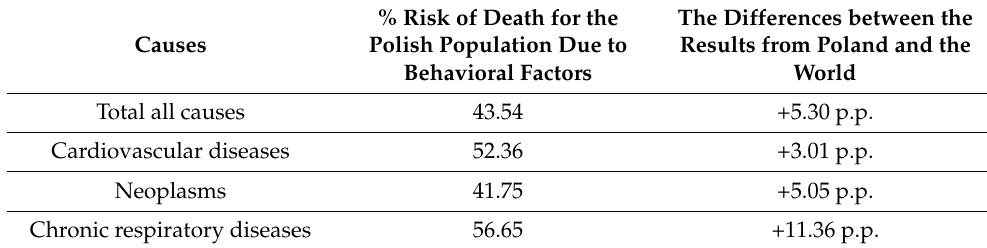
Table 1. Mortality for various diseases due to behavioral factors. The Differences between the % Risk of Death for the Results from Poland and the Causes Polish Population Due to World Behavioral Factors Total all causes 43.54 +5.30 p.p. Cardiovascular diseases 52.36 +3.01 p.p. Neoplasms 41.75 +5.05 p.p. Chronic respiratory diseases 56.65 +11.36